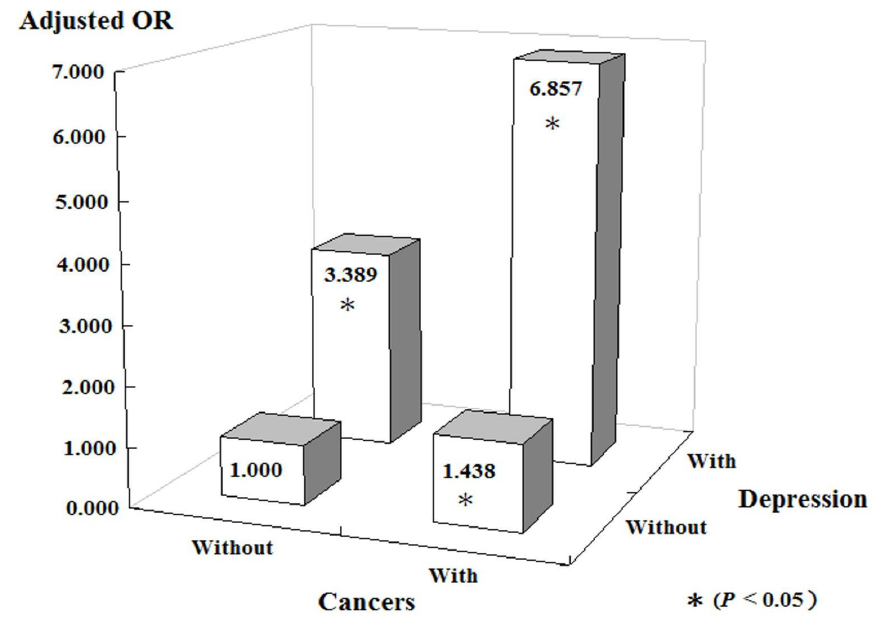
Figure 2. Incidence of cancers stratified by sleep disorders and depression using conditional logistic regression. OR, odds ratio.